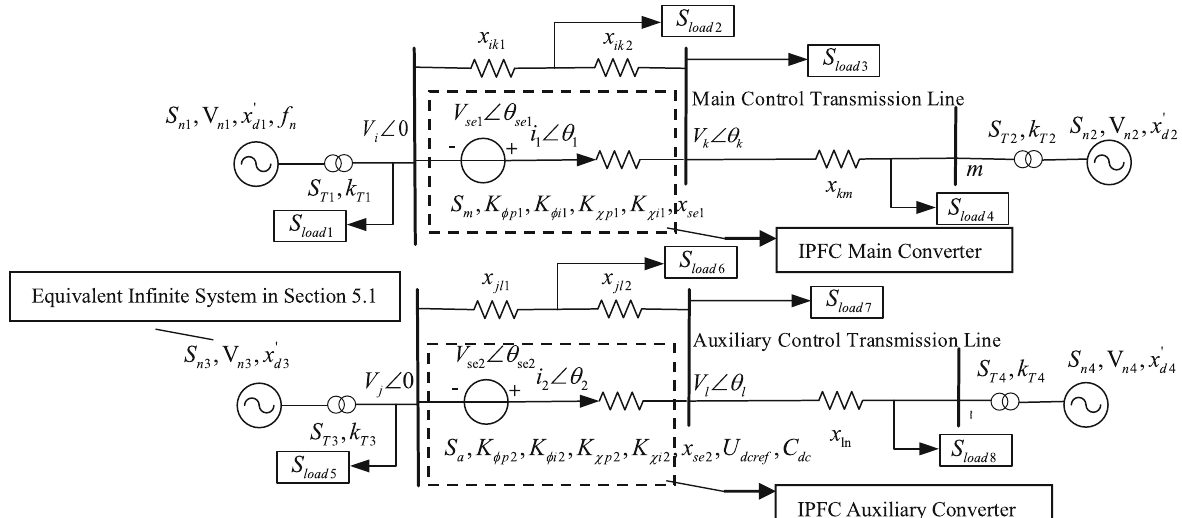
Fig. 7 An equivalent four-machine systems with